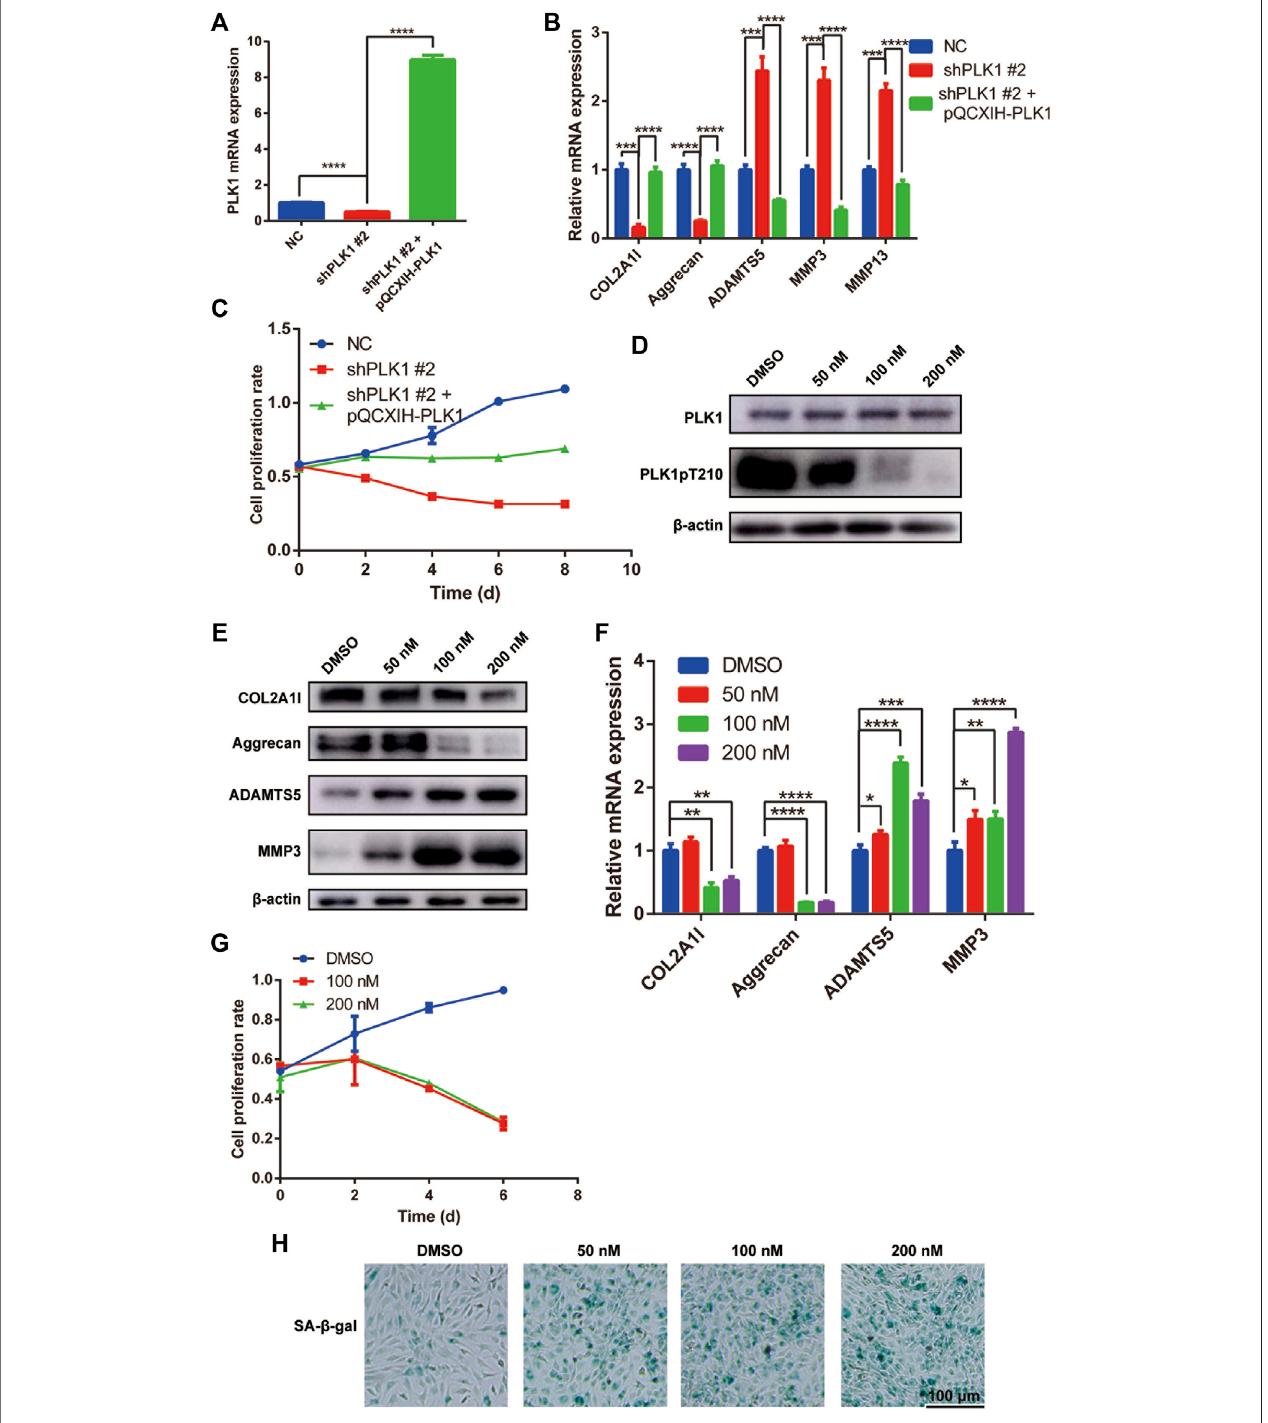
FIGURE 3 | PLK1 overexpression reverses the effects caused by PLK1 shRNAs, and the PLK1 kinase inhibitor volasertib inhibits proliferation and induces senescence in NPCs. (A) The ef fi ciency of PLK1 knockdown (shPLK1 #2) and overexpression (pQCXIH-PLK1) in NPCs. (B) The mRNA expression of collagen, aggrecan, ADAMTS5, MMP3, and MMP13 in NPC transfected with shPLK1 #2 and pQCXIH-PLK1. (C) CCK8 assay was used to detect cell proliferation at the 0, 2nd, 4th, 6th, and 8th day after NPCs were transfected with PLK1 shRNA and overexpression virus. (D) The expression of PLK1 and PLK1 pT210 after inhibiting the PLK1kinaseactivity. (E,F) Theexpressionofcollagen,aggrecan,ADAMTS5,andMMP3afterinhibitingthePLK1kinaseactivitydetectedbyqPCRandwesternblot. (H) CCK8assaywasusedtodetectcellproliferationatthe0,2nd,4th,and6thdayaftertreatmentwith100and200 nMvolasertib. (H) SenescenceofNPCswasmeasured by SA- β -Gal assay after treatment with volasertib. All experiments were performed in duplicates, and data are reported as the mean ± SD. * p < 0.05, ** p < 0.01, *** p < 0.001, **** p < 0.0001. SD, standard deviation.